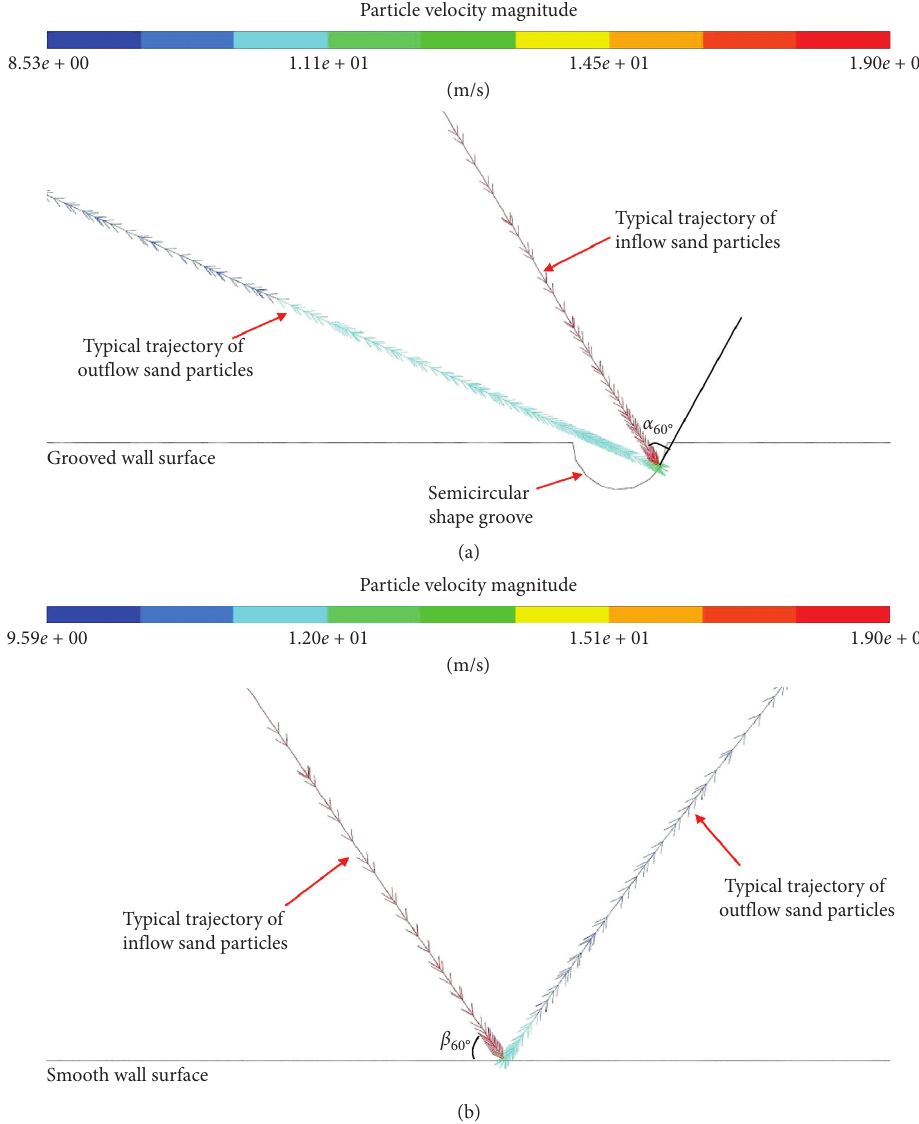
Figure 5: Typical trajectories of sand particles interaction with concrete wall surfaces at the impact angle of 60 ° and wind velocity of 19m/s: (a) grooved; (b)